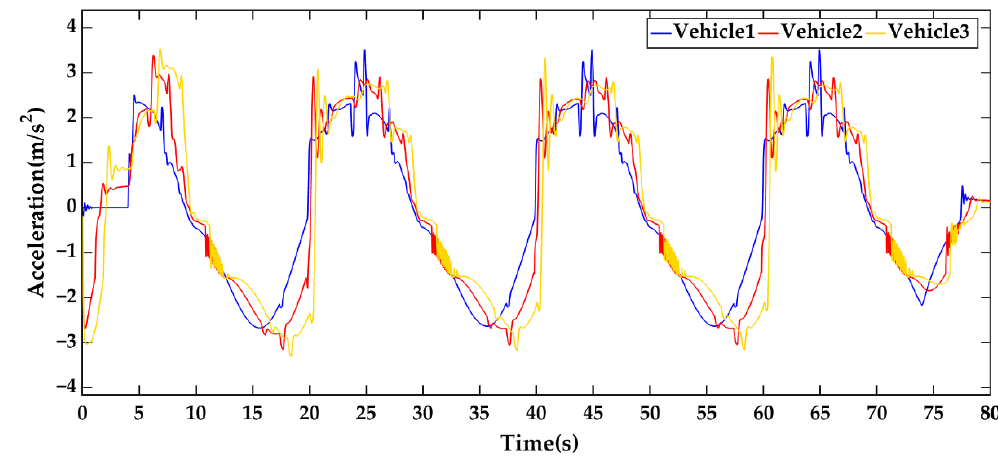
Figure 19. The accelerations of the following vehicle under the standard MPC strategy in Scenario 2.